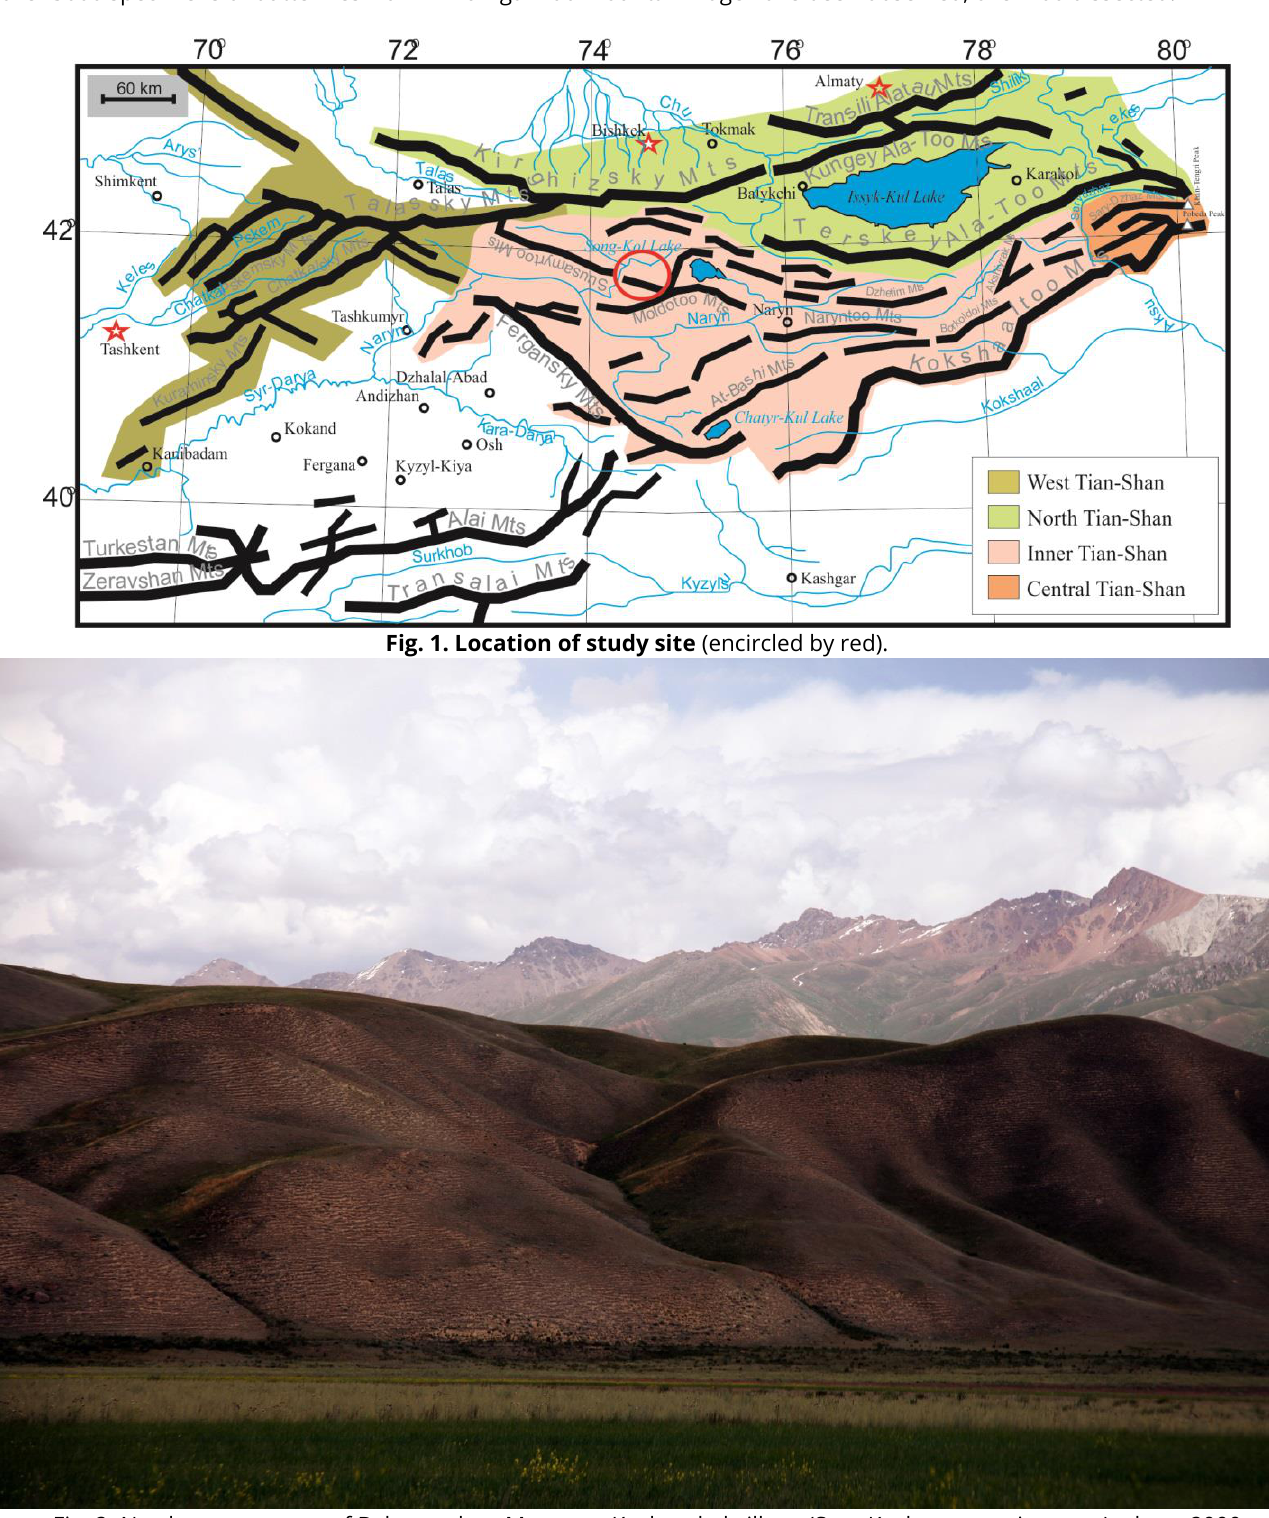
Fig. 2. North-western part of Dzhumgaltoo Mts. near Kozhomkul village (Sary-Kayky mountain gorge), about 2000